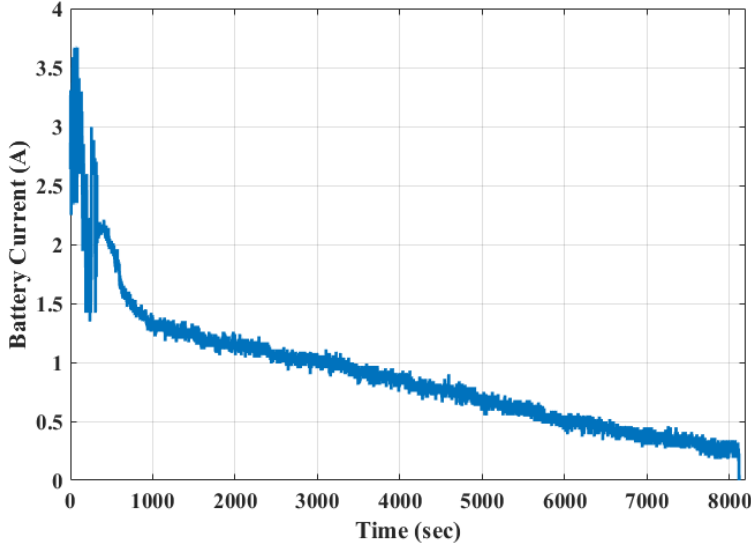
Figure 12. Current profile of the lithium-ion battery using the proposed technique.